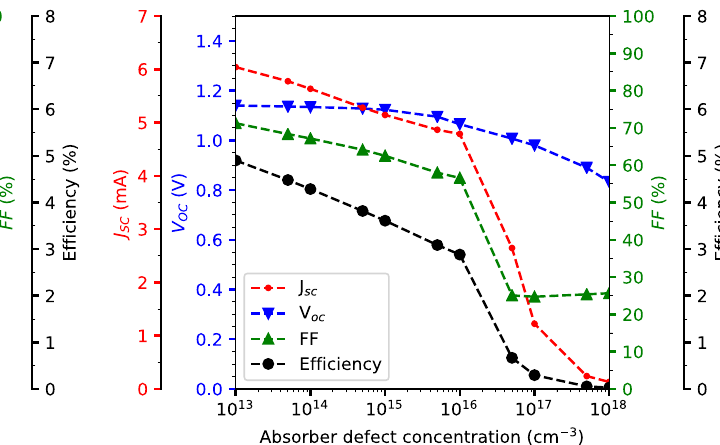
Fig. 5. Evolution of the solar cell performances with the doping concentration using typical physical parameters obtained by the spray pyrolysis process.